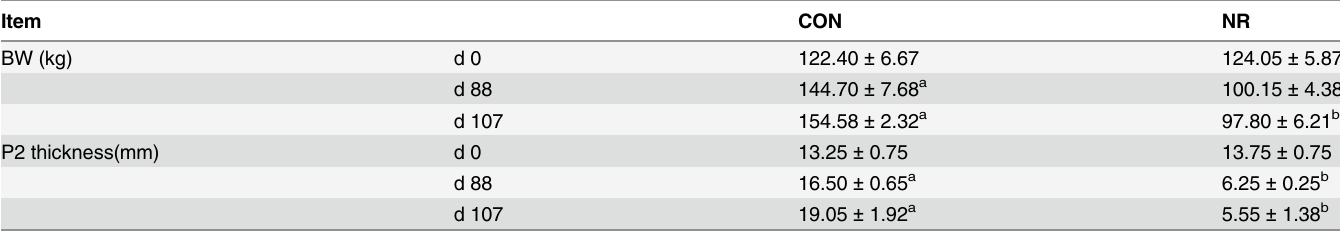
Table 3. Body weight and backfat thickness in normal-fed or nutrient-restricted gilts. Item